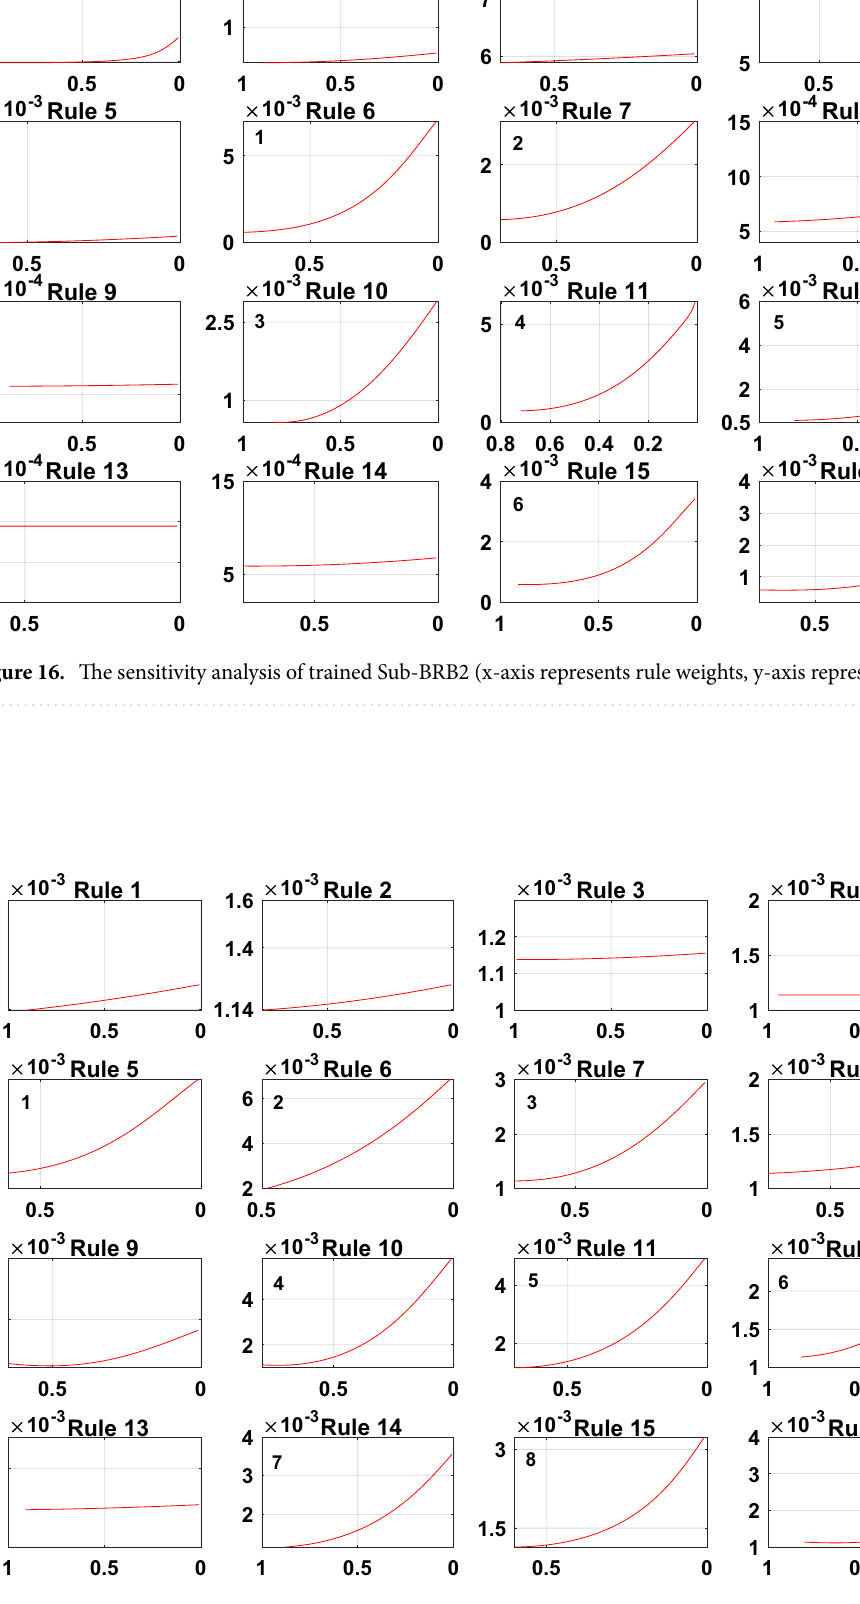
Figure 17. The sensitivity analysis of trained Sub-BRB3 (x-axis represents rule weights, y-axis represents